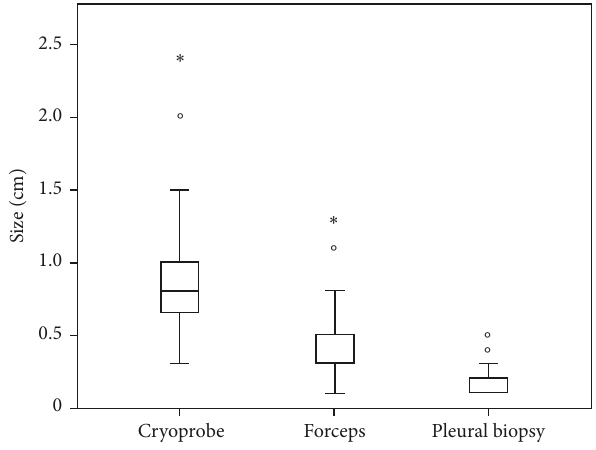
Figure 3: The sample obtained by CB (9.1 ± 4.5mm) was signifi- cantly bigger than the other two methods: FFB (4.0 ± 2.1mm) or CPB (1.9 ± 1.0 mm) ( P < 0 .